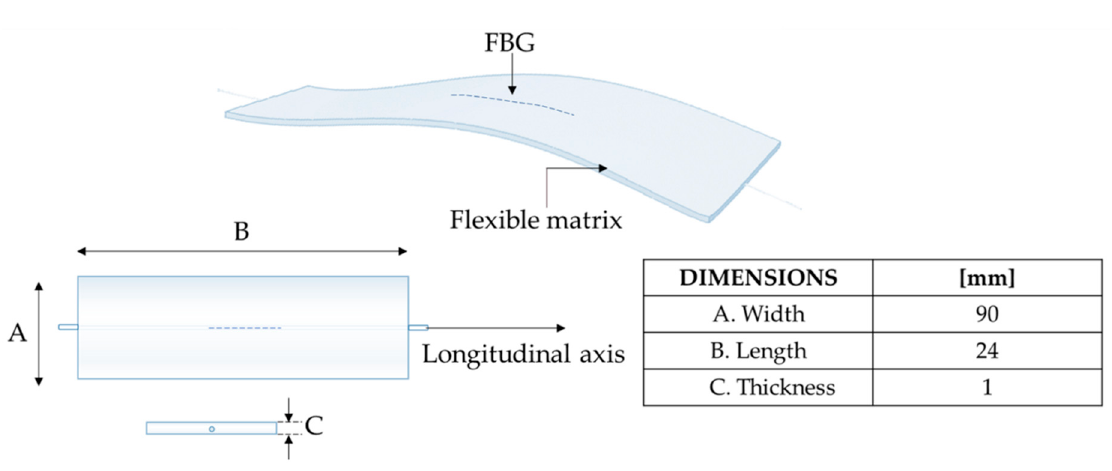
Figure 1. Design and dimensions of the fiber Bragg grating (FBG)-based flexible sensor.